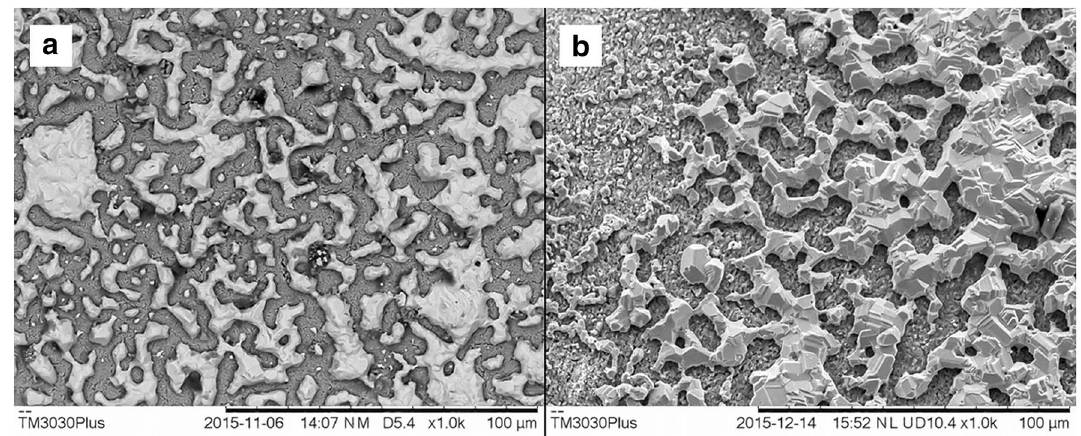
Fig. 6 SEM of the cathode surface covered by Ag: a after 100 h at 650 °C; b after 850 h at 650